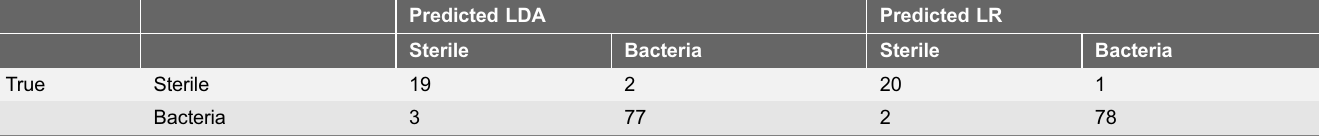
Table 2. Classification results of bacteria vs sterile samples with LDA and LR.